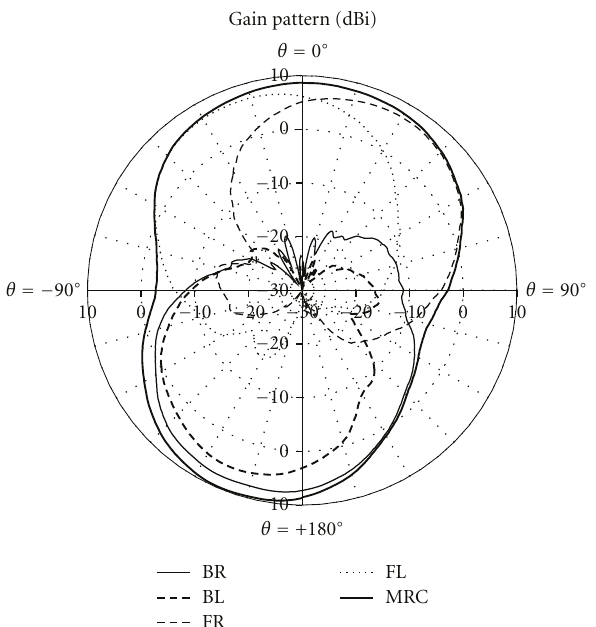
Figure 3: Radiation patterns of four circularly polarized antennas mounted into the garment and worn by the firefighter. The antenna locations are listed in the legend: back right (BR), back left (BL), front right (FR) and front left (FL). The curve labeled MRC displays the combined power over the four antennas (the gain of the smart antenna system after applying MRC); a positive gain in dBi is realized over 255 ◦ of azimuth